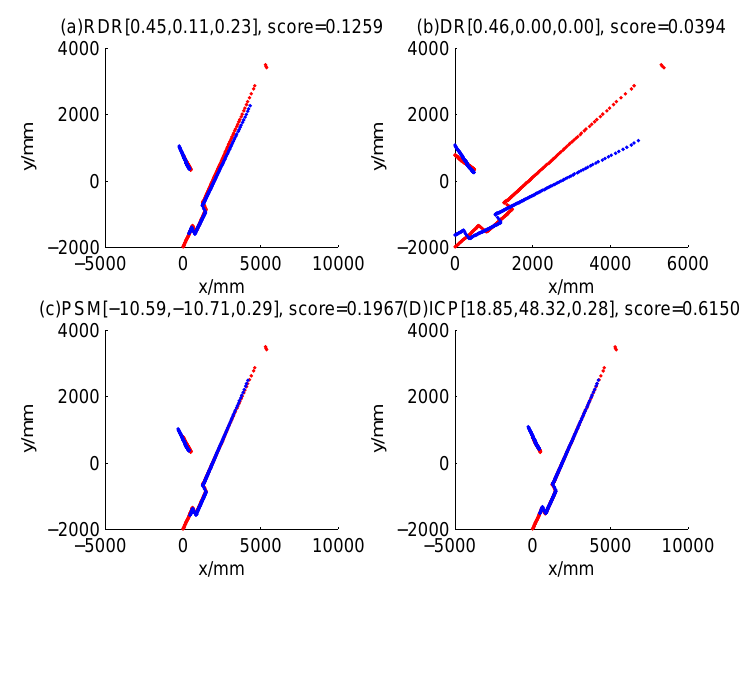
Figure 24. Robust dead reckoning result for Case 4b (time Step 17).